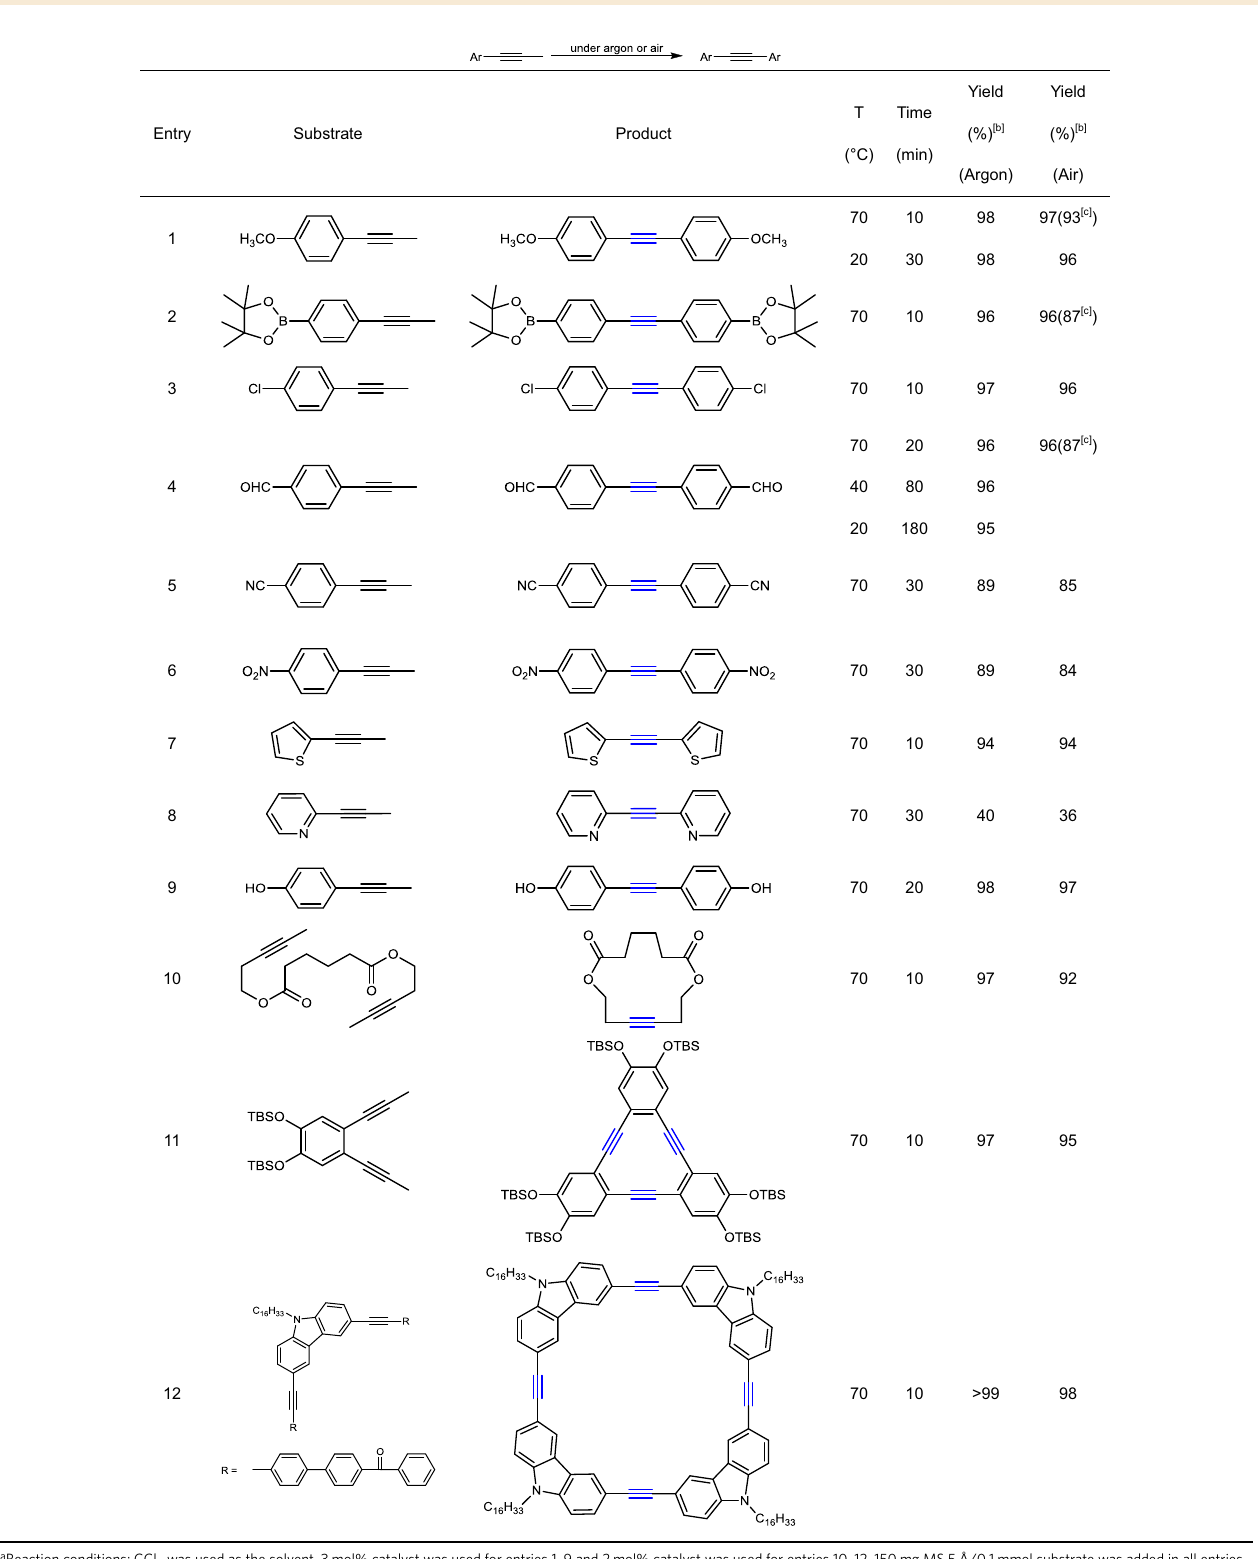
Table 2 Homodimerization, RCAM, and cyclooligomerization reactions of propynyl substrates either under argon or air condition a